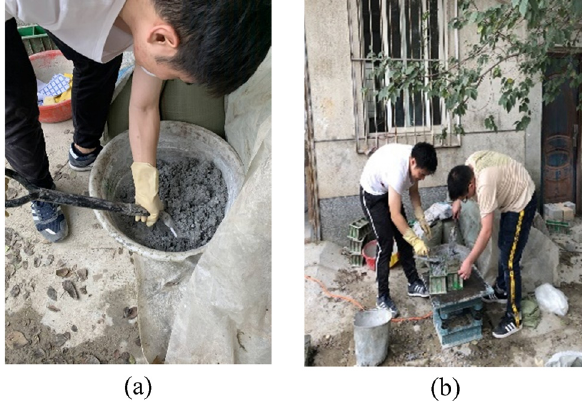
Figure 3: The process of casting concrete samples: ( a ) mixing concrete and ( b ) fi lling in the mold.